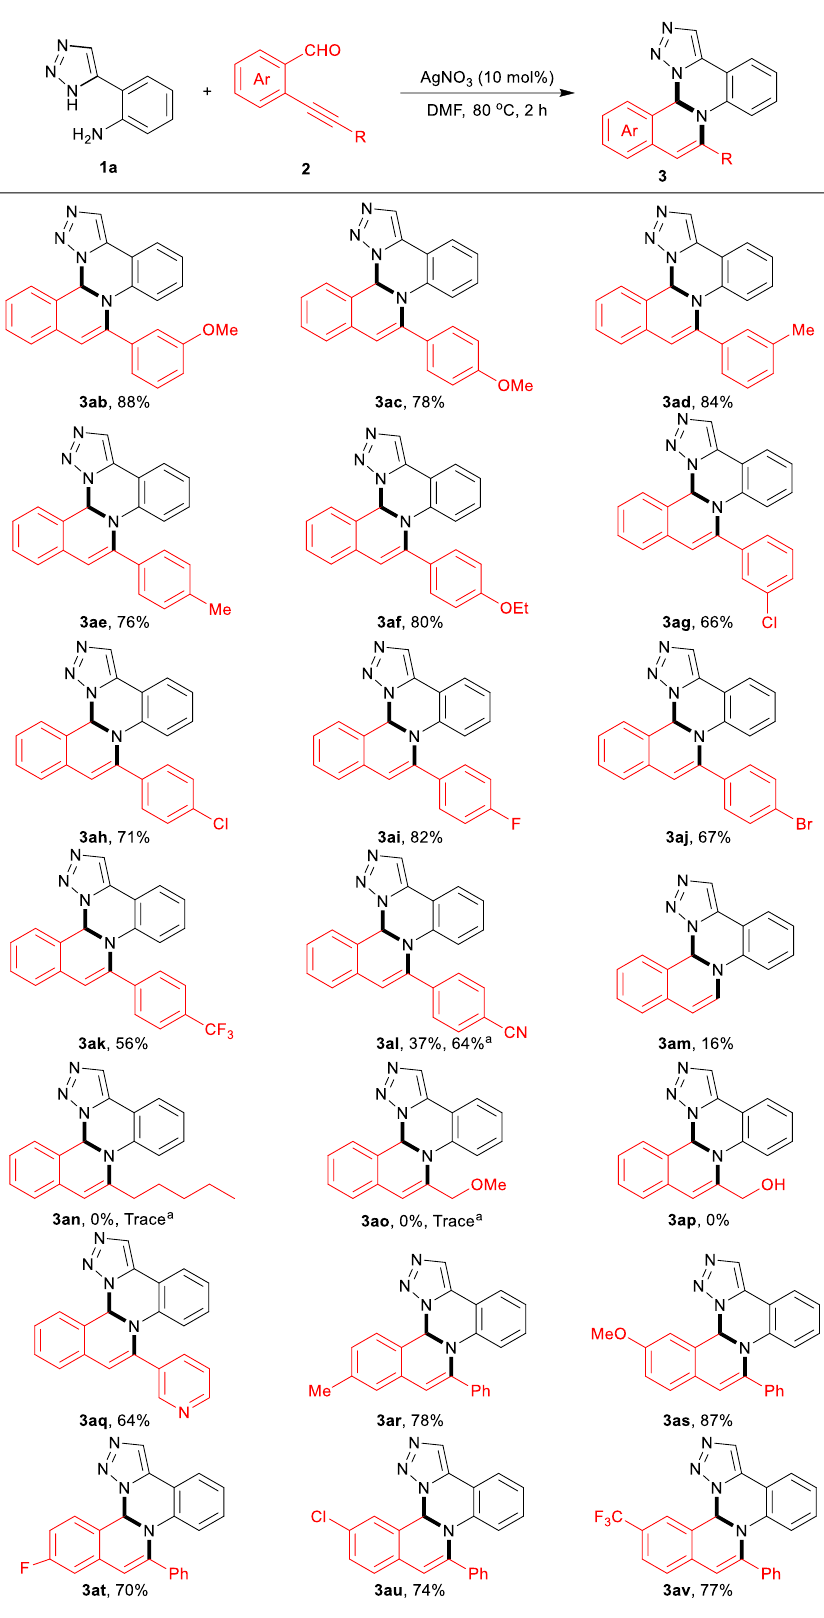
Figure 2. Scope of 2-alkynylbenzaldehyde. . Reaction conditions: 1a (0.2 mmol), 2 (0.2 mmol), AgNO 3 (10 mol%) in DMF (1 mL) at 80 ◦ C for 2 h. Isolated yield. a AgBF 4 instead of AgNO 3